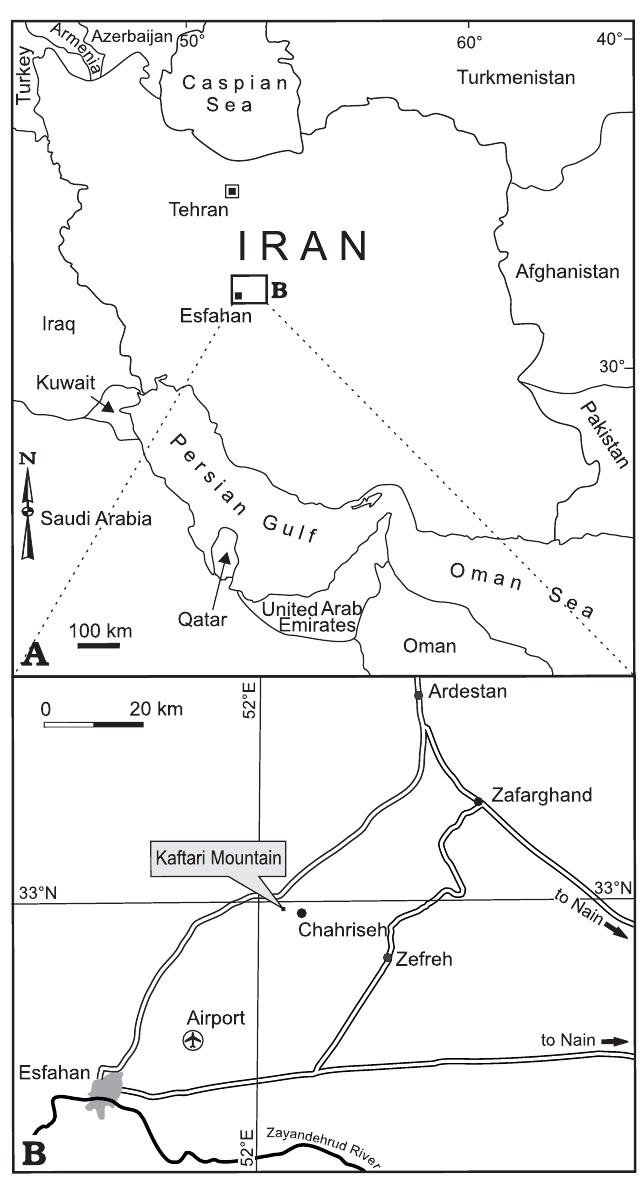
Fig.1. Map of Iran ( A ) and close−up of the Chahriseh area showing location of the Kaftari Mountain section ( B